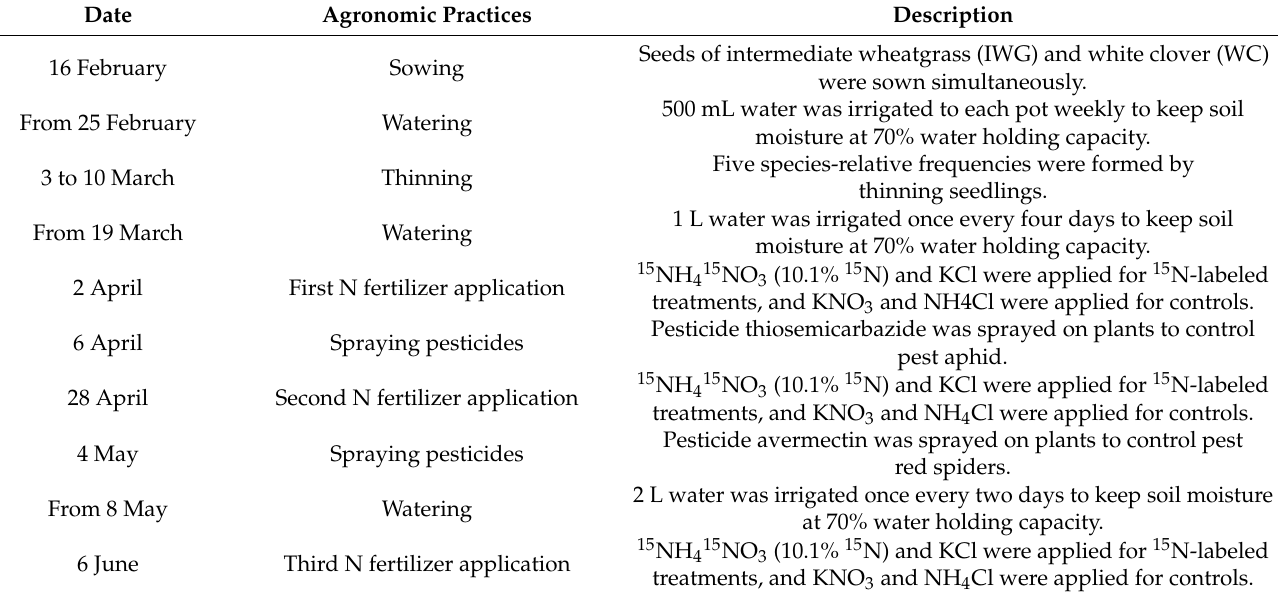
Table 1. The description of agronomic practices and